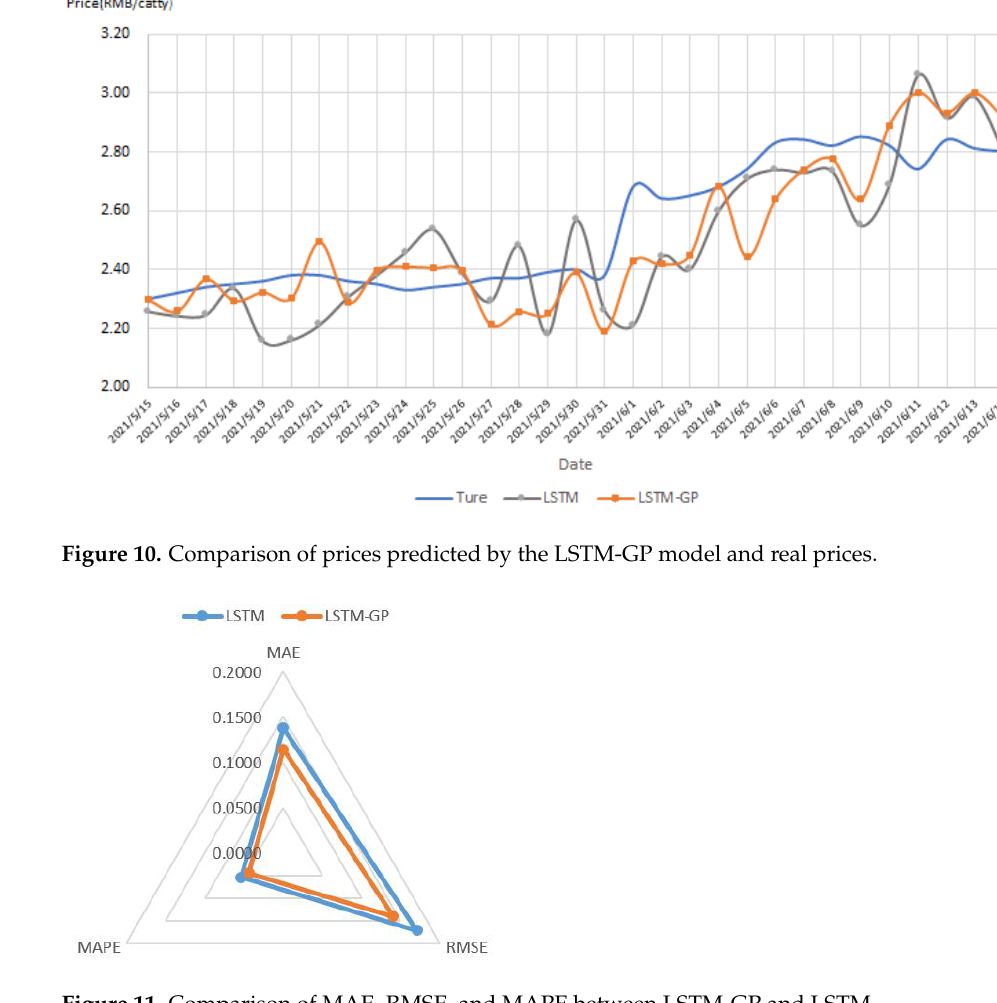
Figure 11. Comparison of MAE, RMSE, and MAPE between LSTM-GP and